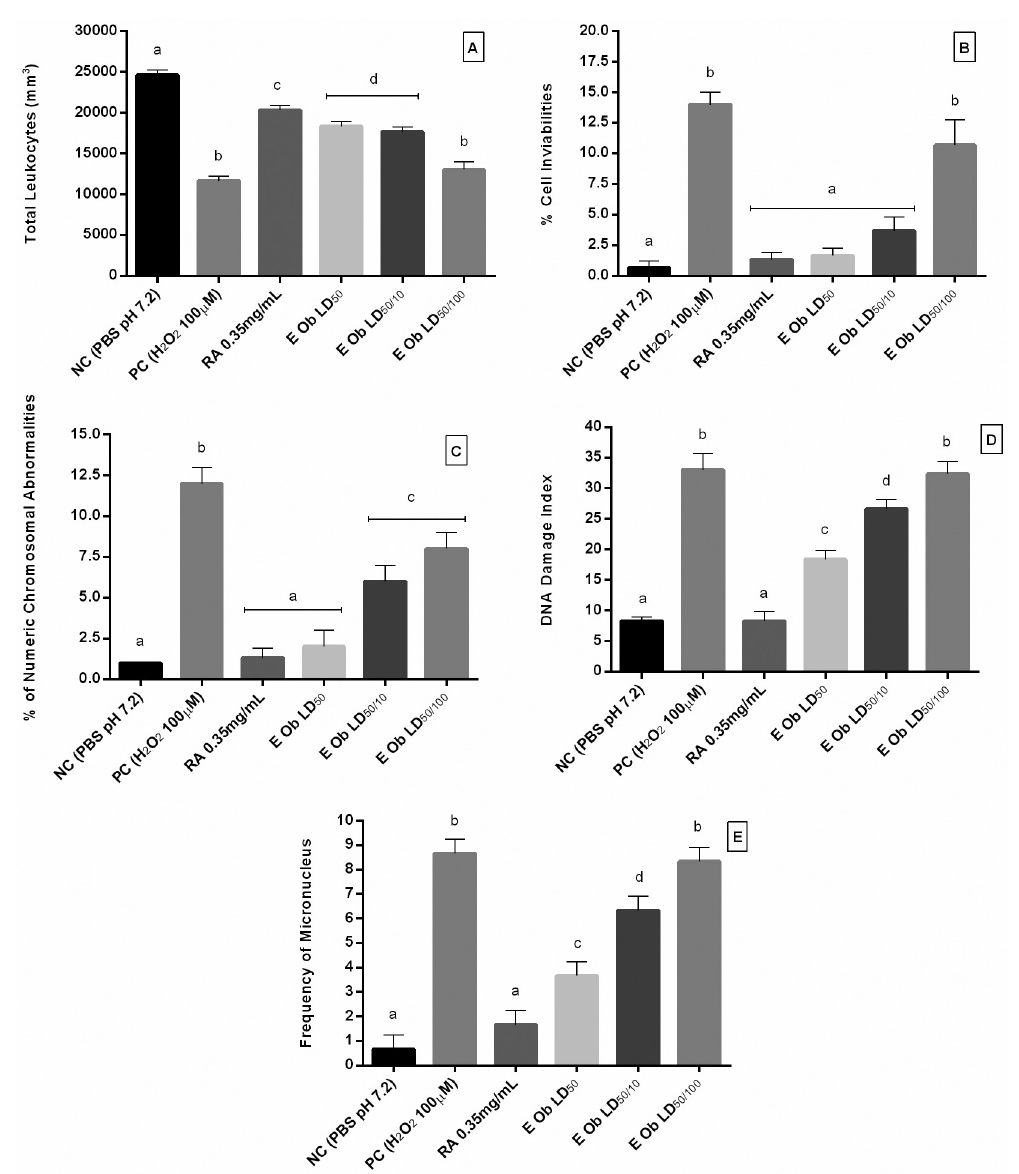
FIGURE 3 - Effects of O. basilicum extract in anti-genotoxic parameters of human leukocytes in culture subject to hydrogen peroxide. In A: cell proliferation; B; cell inviability; C: percentage of abnormal chromossomics; D: DNA damage index; E: frequency of micronuclei. NC: negative control; PC: positive control; RA: rosmarinic acid; LD50: concentration equals to LD50 (35.44 µg/ mL); LD50/10: 10 times less the concentration of LD50 (3.544 µg/mL); LD50/100: One hundred times less the concentration of LD50 (0.3544 µg/mL). Data are expressed as mean ± S.D. Results were confirmed by an experiment that was repeated three times. Different letters represent statistically different results among columns (p <